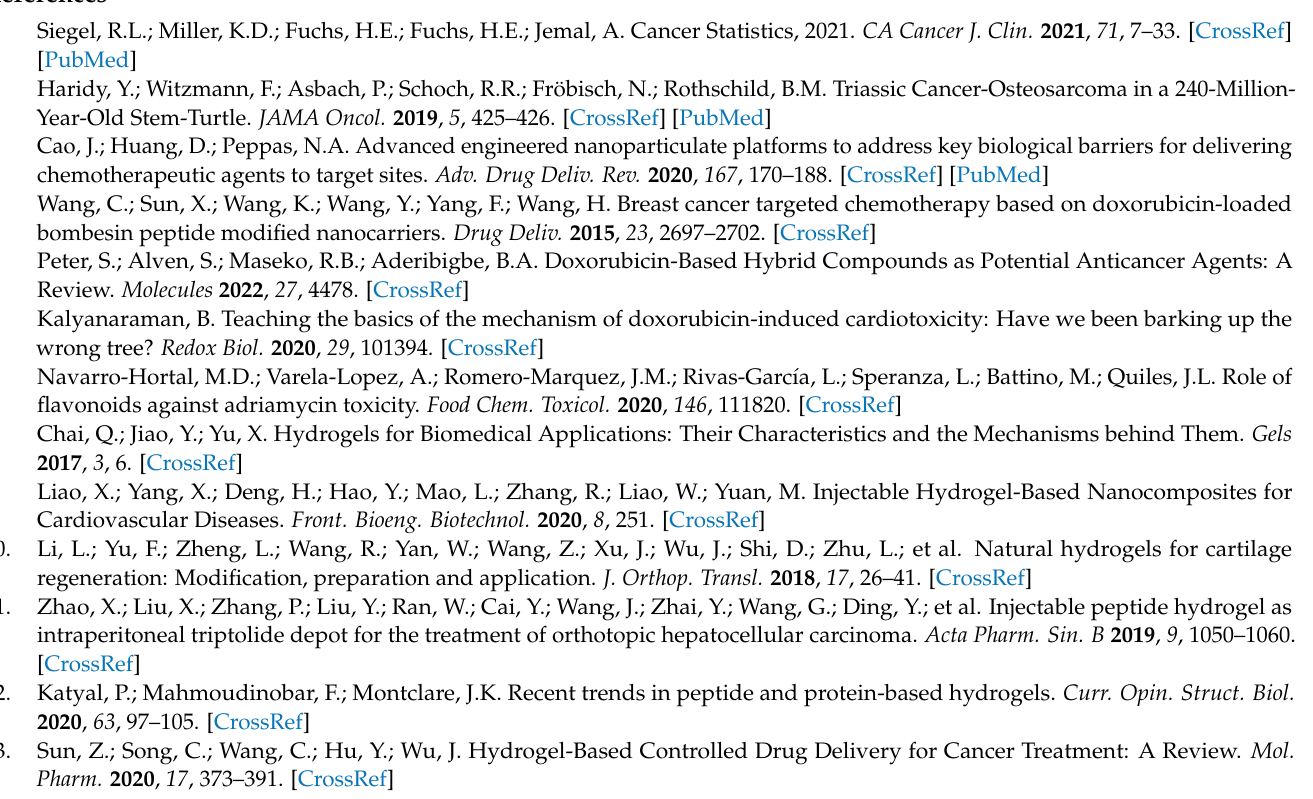
Table S3. Summary of phase behavior of peptides in different concentration; Figure S1. The UPLC chromatograms and peak data of designed nonapeptides; Figure S2. The mass spectrum of P1 peptide; Figure S3. Cumulative release of Dox from DOX-P2 hydrogel; Figure S4. Transmission electron microscopy of drug loaded